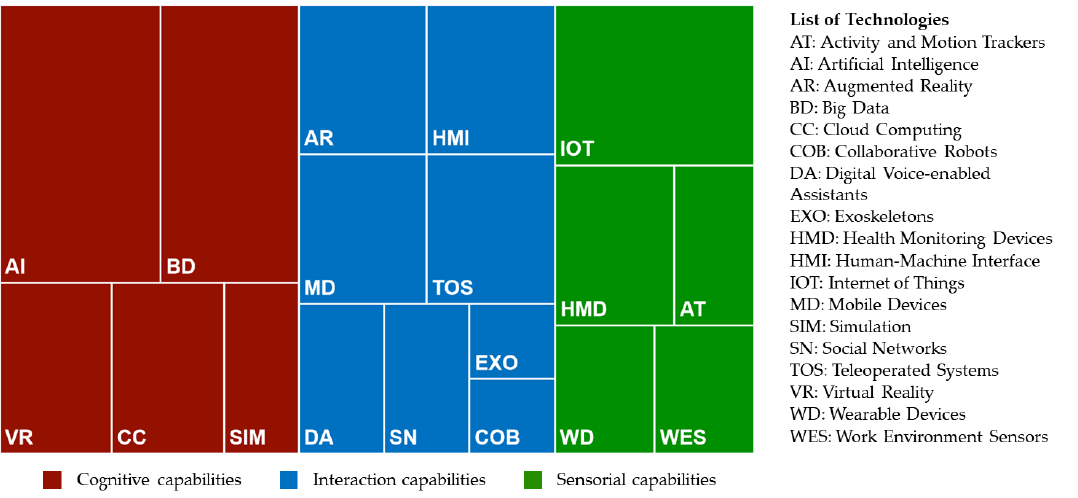
Figure 4. Treemap chart of the perceived beneficial impact of Operator 4.0 enabling technologies. 340